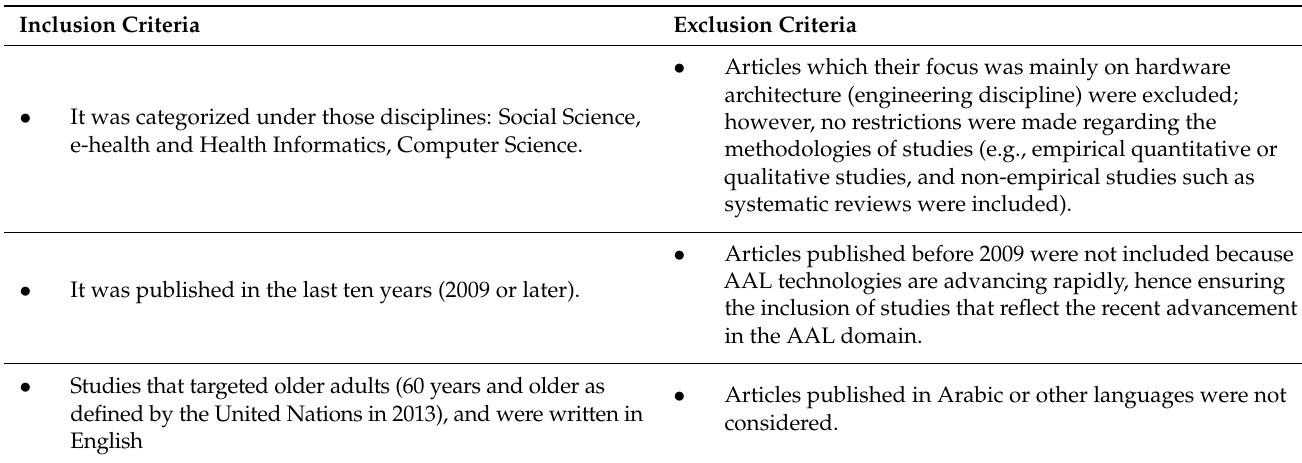
Table 1. The inclusion and exclusion